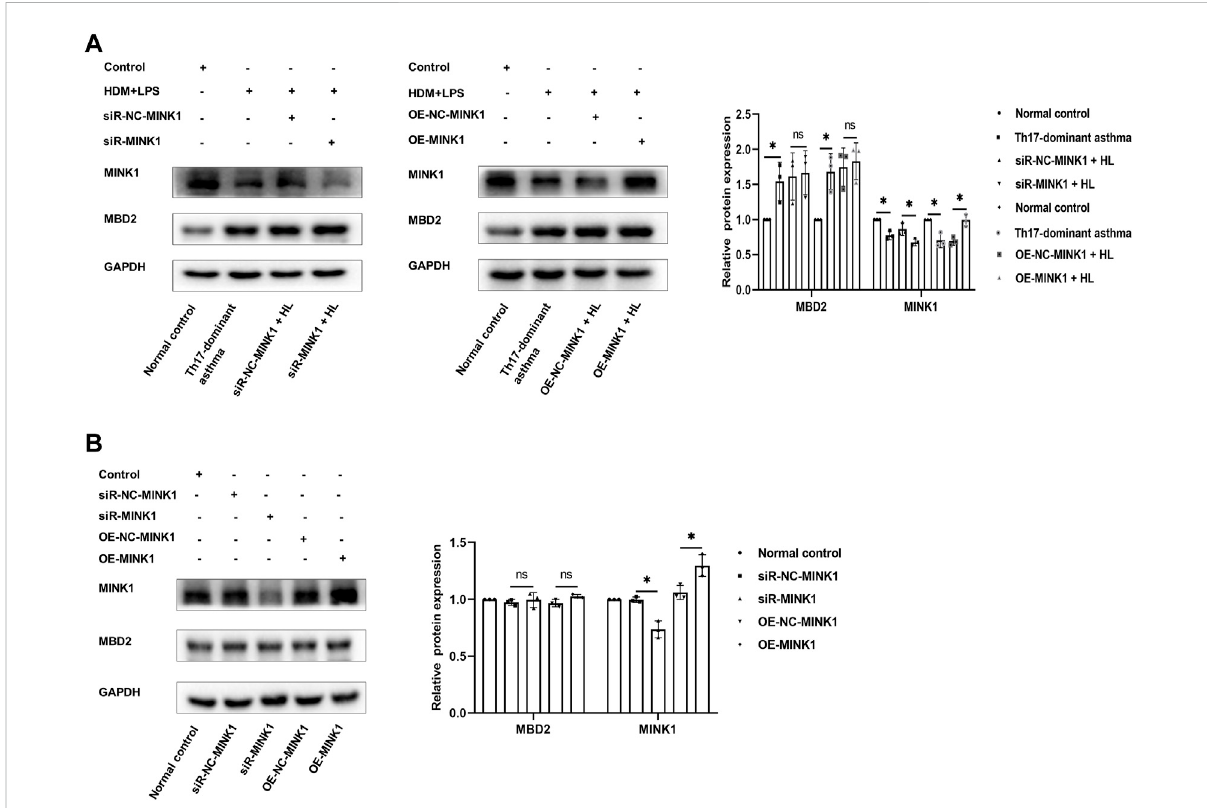
FIGURE 4 MBD2 is needed to maintain MINK1 silencing (A, B, E, and F) Western blot and qRT-PCR were used to verify the transfection of the MINK1 gene with or without HDM + LPS exposure. (A, B, E, and (F) Western blot and qRT-PCR were used to detect the expression of MBD2 protein and mRNA in MINK1 gene silencing or overexpression with or without HDM + LPS exposure (C, D, E, and (F) Western blot and qRT-PCR were used to verify the transfection of the MBD2 gene with or without HDM + LPS exposure. (C,D,E and F) Western blot and qRT-PCR were used to detect the expression of MINK1 protein and mRNA in MBD2 gene silencing or overexpression with or without HDM + LPS exposure (G) The patterns of CpG islands of the MINK1 promoter and one pair of the primers were predicted by MethPrimer Promoter 2.0 software. (H) Quantitative PCR results